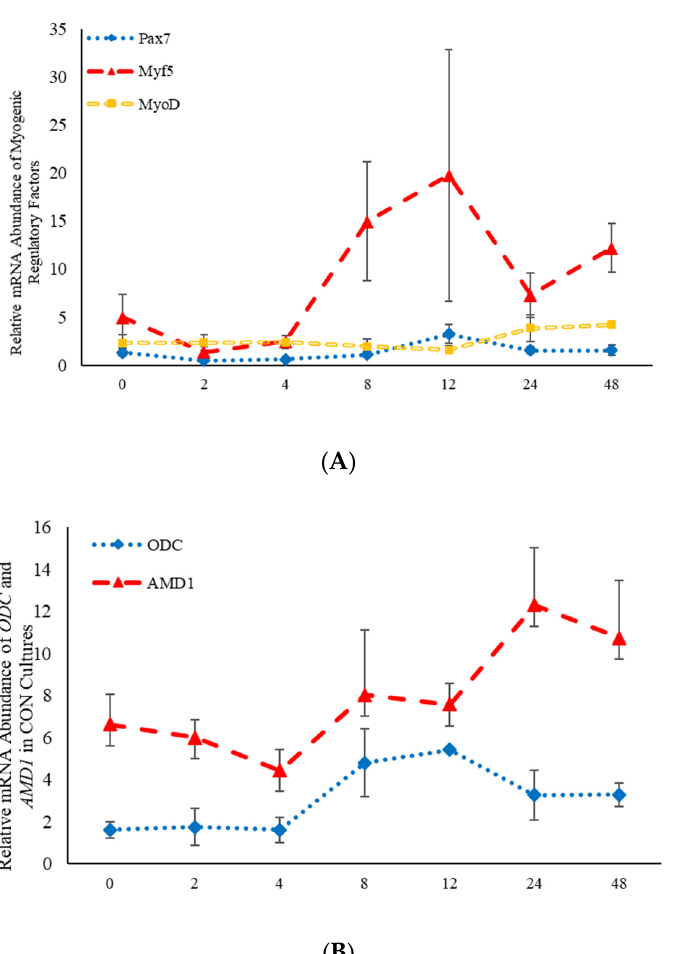
Figure 1. Relative mRNA abundance of the myogenic regulatory factors ( A ): paired box transcription factor 7 ( Pax7 ) , myogenic factor 5 (Myf5 ) , and myogenic differentiation factor 1 (MyoD ) and relative mRNA abundance of the two rate limiting steps involved in the polyamine biosynthesis pathway ( B ): S-adenosylmethionine decarboxylase (AMD1) and ornithine decarboxylase (ODC) from control- treated primary bovine satellite cells cultures over time. Abundance was measured 0, 2, 4, 8, 12, 24 and 48 h after treatment, as described in the Materials and